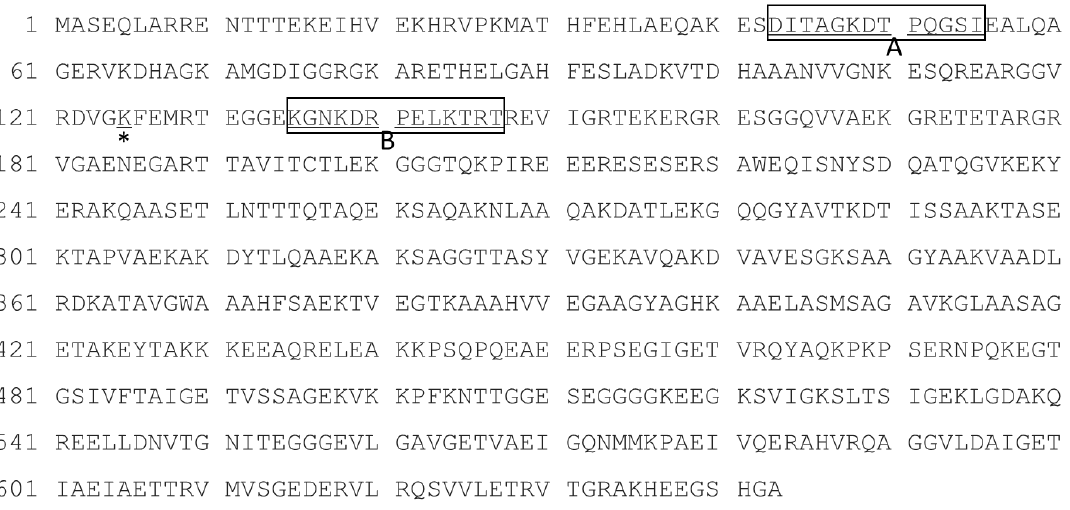
Figure 1. Amino acid sequence of Gly m 7. Selected peptide antigen regions for antibody production are indicated as box A and box B. The putative biotin binding Lys (k) residue is indicated by * at 125 aa. The sequence data was referred from UniProtKB-C6K8D1 (C6K8D1_SOYBN) (Allergome 10214, Gly m 7.0101).